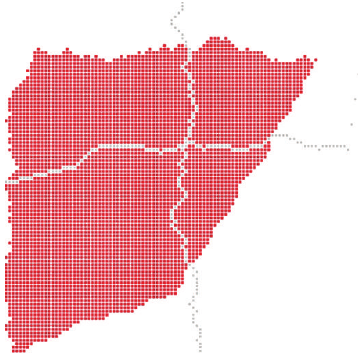
Figure 1: Representation method of land plot with complex